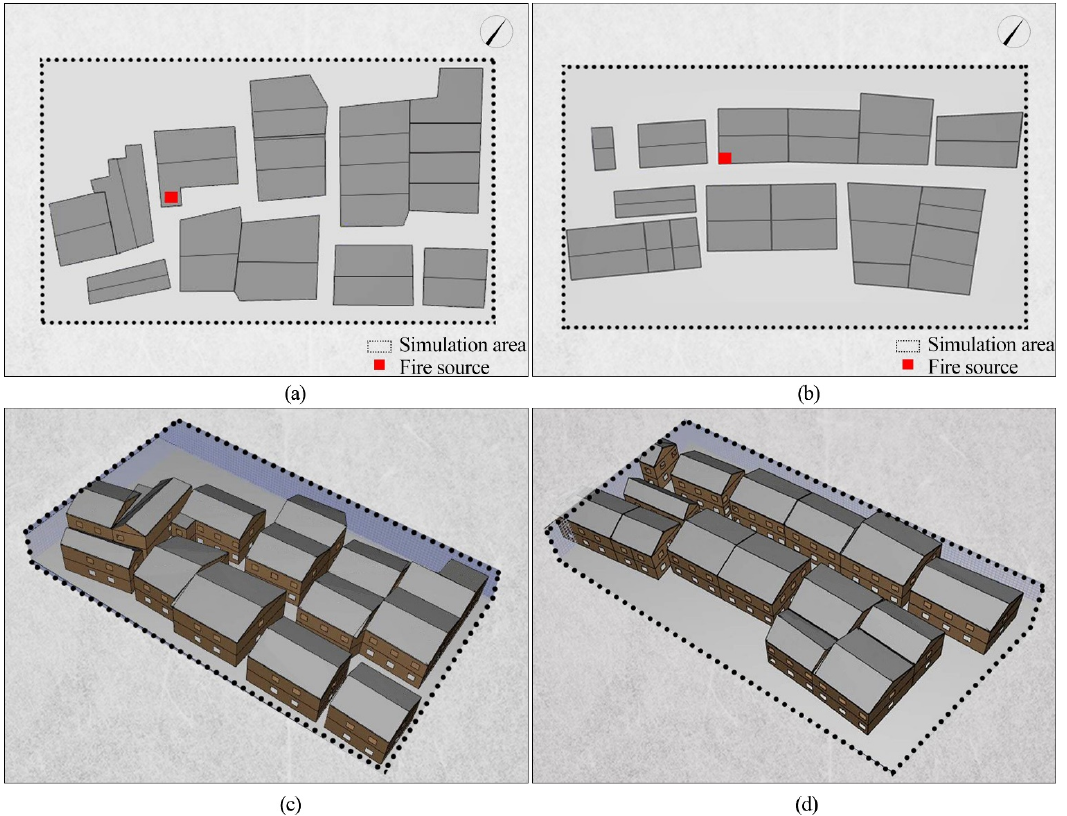
Figure 11. ( a ) Plan view of the simulated crooked street; ( b ) plan view of the simulated straight street; ( c ) simulation model of the crooked street; and ( d ) simulation model of the straight street. 1. Wind direction. Considering the most hazardous situation, the wind direction was set to the northeast wind commonly encountered in western Hunan, which was the same as the direction of the street. The windspeed was set to 1.5 m/s for both models. 2. The grid size was 0.6 m x 0.6 m x 0.6 m for both models. The grid numbers of the straight street and the crooked street were 92,664 and 86,400, respectively. 3.